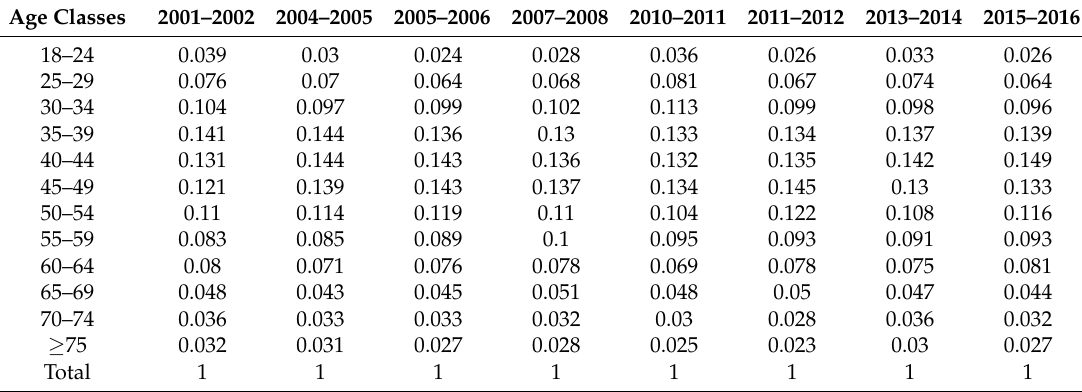
Table 2. Age Composition of Households Head in Relative Term.